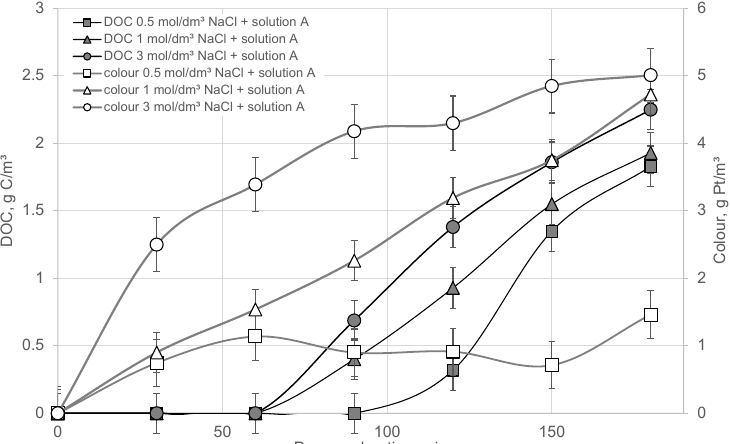
Figure 7. Changes in DOC concentration and colour intensity in the draw solution with the FO process duration.